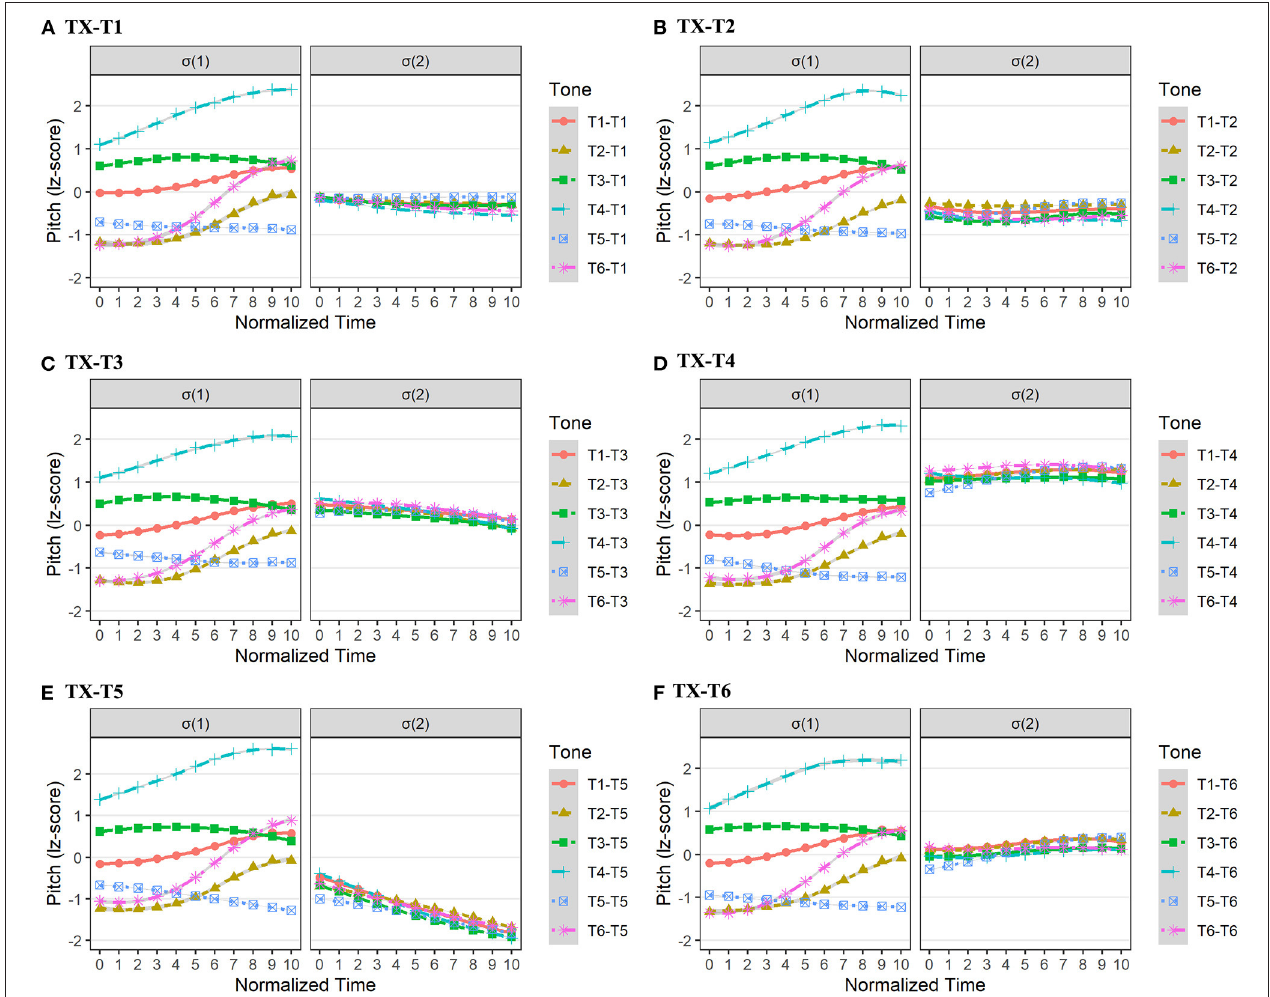
FIGURE 4 | The pitch realizations of σ (1) and σ (2) in Changsha dialect with tonal combinations of TX-T1 (A) , TX-T2 (B) , TX-T3 (C) , TX-T4 (D) , TX-T5 (E) , and TX-T6 (F) .